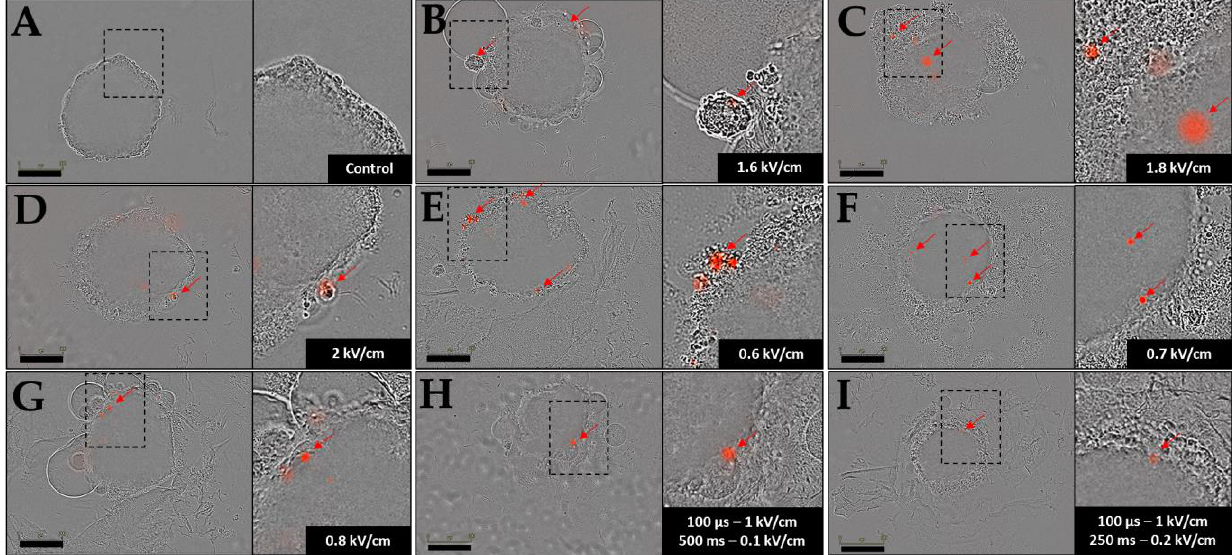
Figure 8. Representative HCT-116 spheroids images following the transfection attempt. Spheroids were incubated with 40 µg/mL plasmid encoding tdTomato and observed 24 h after pulsation by bright field/fluorescence wide-field microscopy. Transfected areas are indicated with red arrows.